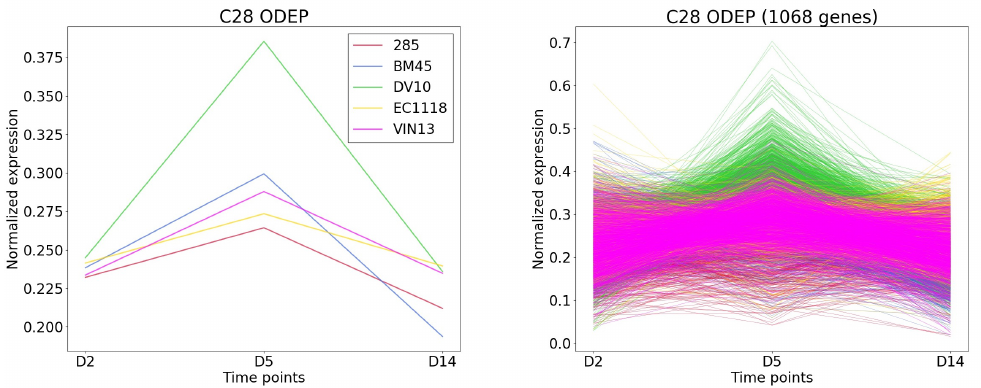
Figure 8. The cluster and gene patterns of cluster 28 which express gene highest in DV10 strain for case study